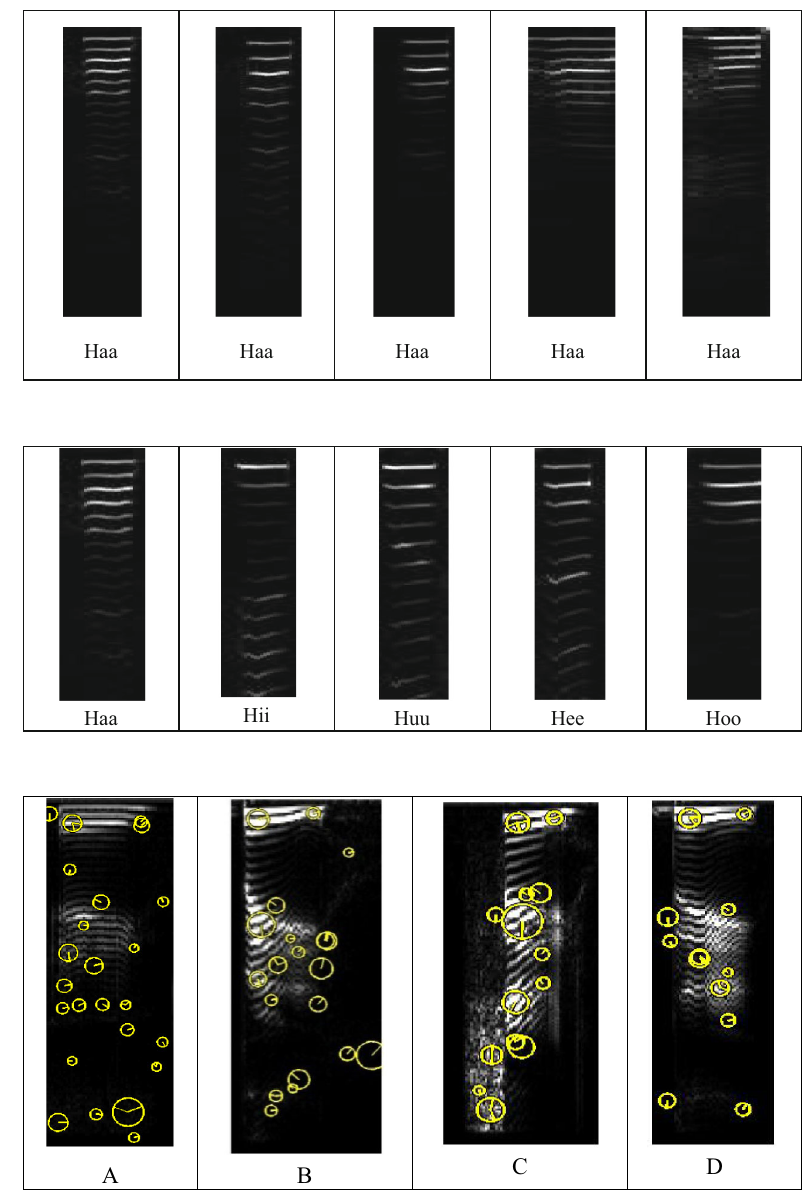
Fig. 5 SIFT features from some English alphabet A , B ,